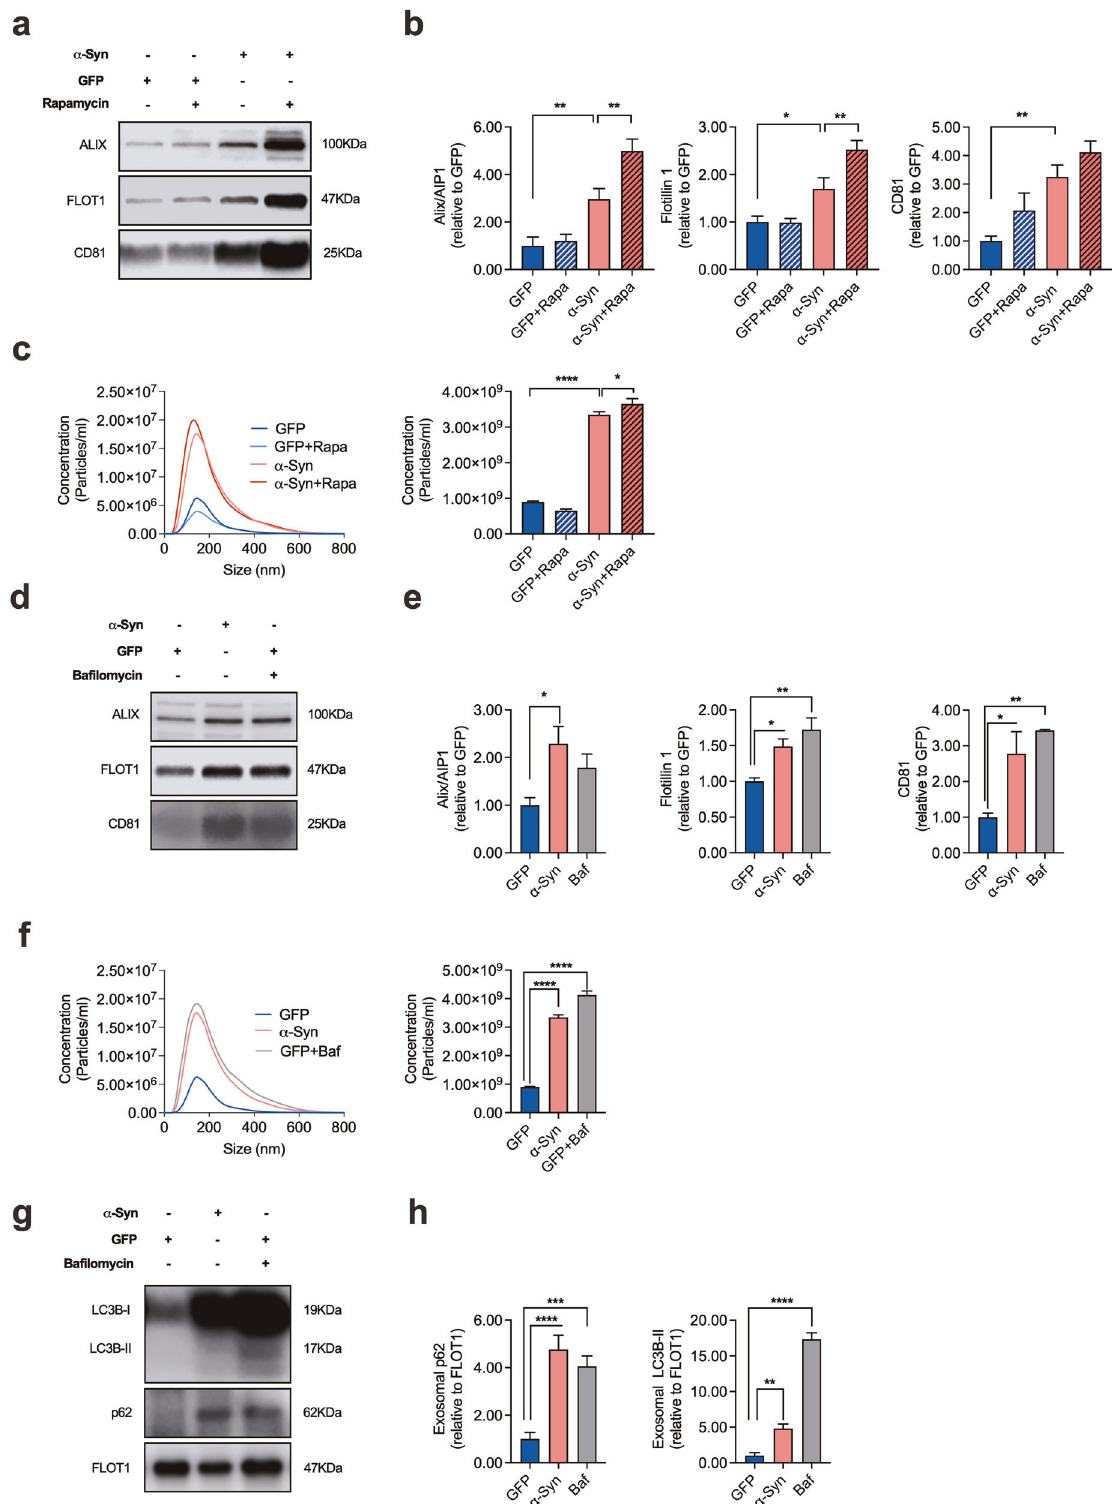
family members SNAP23 and SNAP29 in α -Syn-transduced cells (Fig. 3a, b). On the other hand, the abundance of VAMP8, STX17, and YKT6 remained unchanged (Fig. 3a, b), thus suggesting a family-speci fi c effect of α -Syn. Interestingly, α -Syn overexpression had no effect on SNAP29 gene expression as measured by